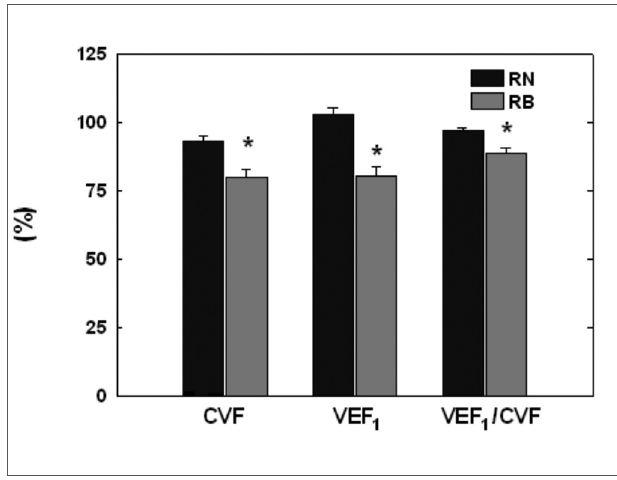
Figura 2. Variáveis espirométricas. RN = grupo de crianças respirado- ras nasais; RB = grupo de crianças respiradoras bucais; CVF = capa- cidade vital forçada; VEF1 = volume expiratório forçado no primeiro segundo; * significativamente diferente com relação a RN (p< 0,05).